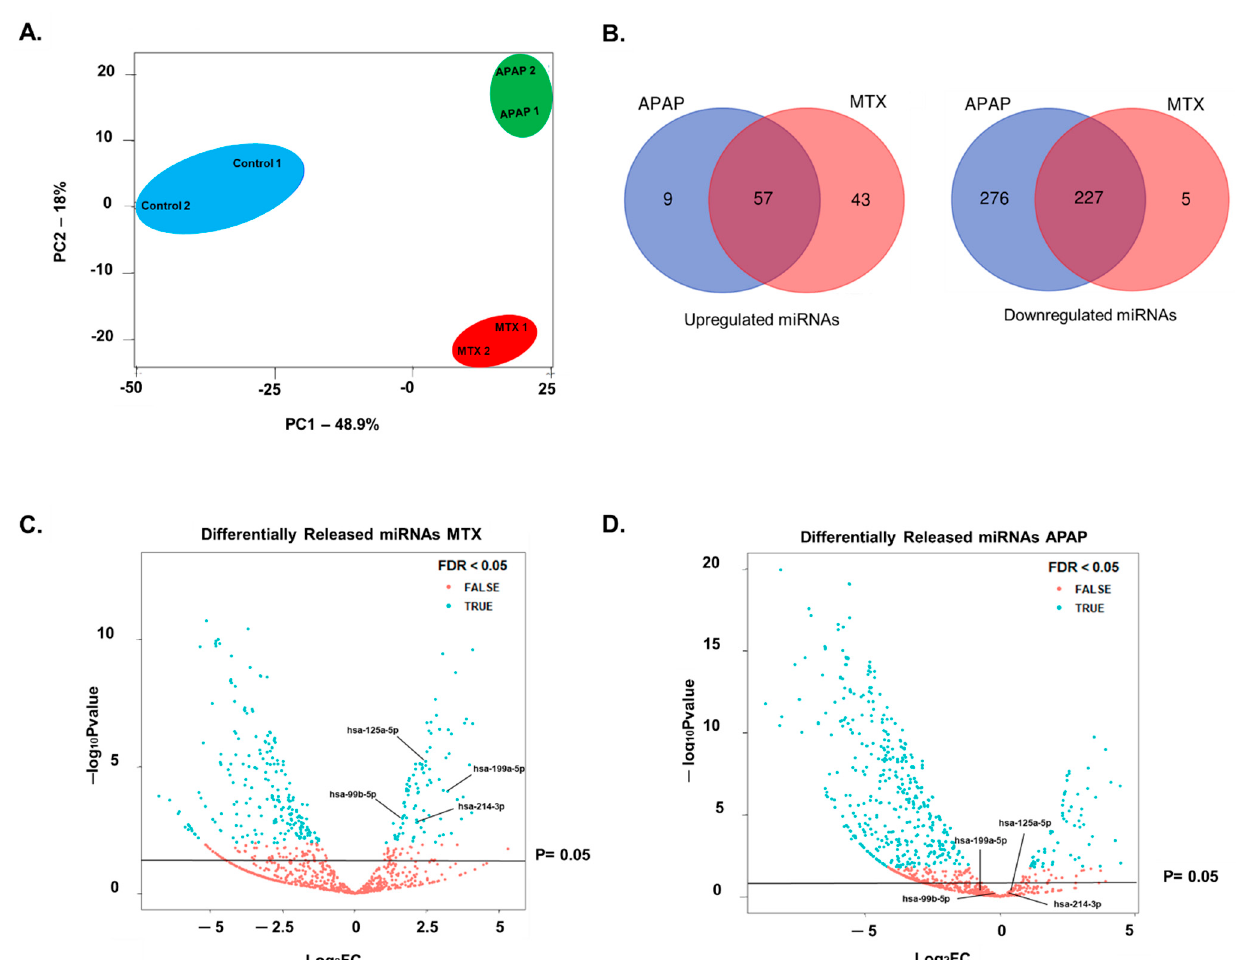
Figure 4. Using NGS to investigate miRNAs released by MTs treated with MTX and APAP. Cell culture supernatant from MTs exposed to MTX and APAP for 10 days were collected to perform miRNA analysis using NGS. PCA analysis of differentially released miRNAs was carried out using R as described in methods section ( A ). NGS demonstrated that MTX and APAP differentially released miRNAs. Venn diagram results show that release was increased for 57 and decreased for 225 common miRNAs between the treatments ( B ). Four of the MTX-specific miRNAs were chosen based on the literature search and volcano plots for MTX ( C ) and APAP ( D ) demonstrate the release of the four miRNAs (miR-199a-5p, mIR-214-3p, miR-125a-5p and miR-99b-5p) is significantly increased by MTX treatment but not APAP.